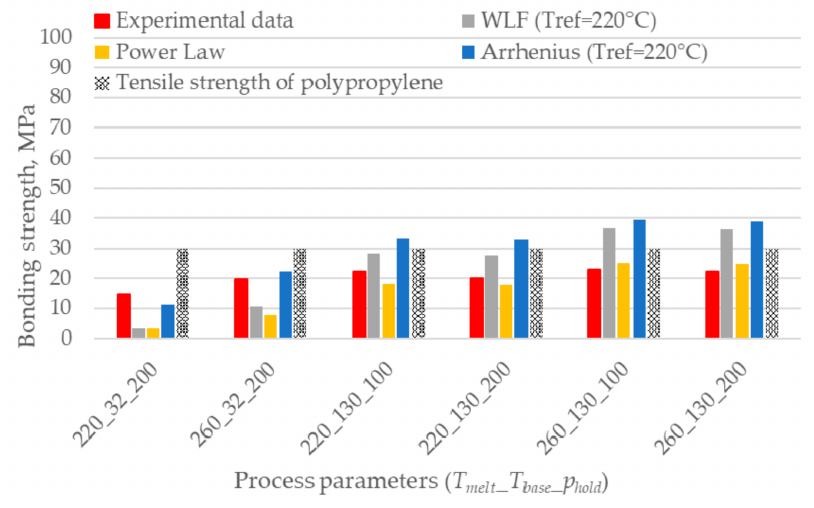
Figure 8. Comparison between the experimental bonding strength and the predictions based on the first 0.9 s of the interface temperature evolution. The combination of process parameters is expressed using the code T melt _ T base _ p hold .